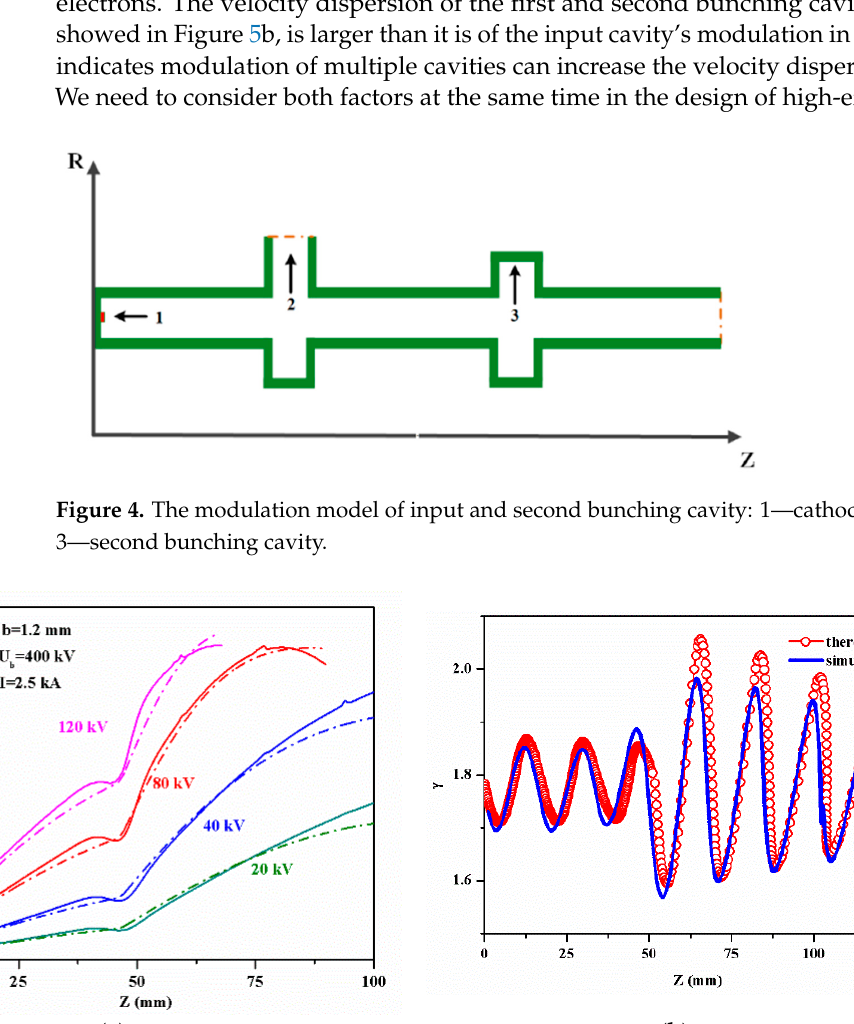
Figure 6. The modulation model of first, second and third bunching cavity: 1—cathode, 2—input cavity, 3—second bunching cavity. ( a ) ( b ) Figure 7. ( a ) The first harmonic current versus different modulation voltage: full lines show theoretical results while dotted lines show simulation results. ( b ) The velocity dispersion versus displacement Z. We compare the theoretical results of velocity dispersion with the simulation results when the modulation voltage is 10 kV, which also shows good consistency in Figure 7b. The velocity dispersion of the first, second and third bunching cavity’s modulation showed in Figure 7b is similar to the first and second bunching cavity’s modulation in Figure 5b. As Figure 7a shows, when the modulation voltage is only 2 kV and 5 kV, the